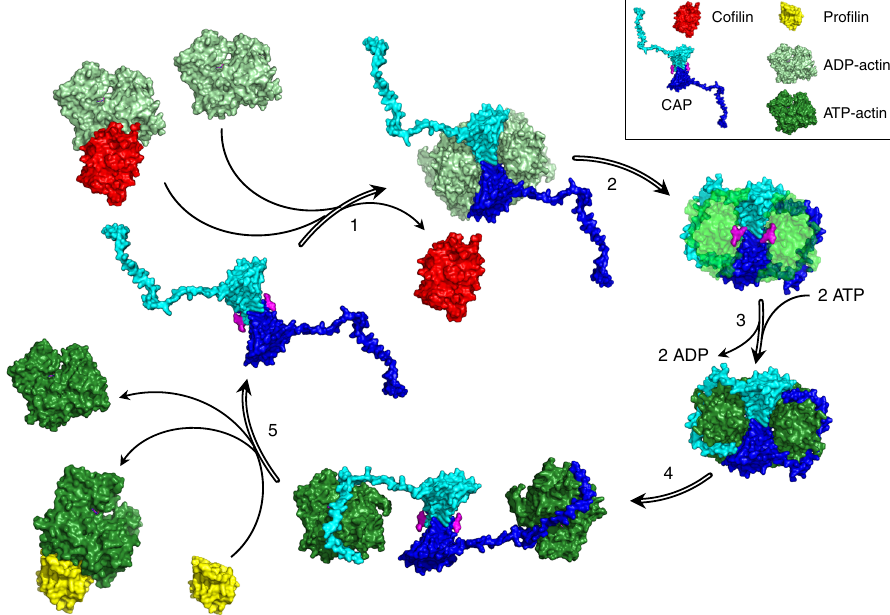
Fig. 6 A working model for how CAP catalyzes nucleotide exchange on actin monomers in cells. (1) CAP can interact with both free and co fi lin-bound ADP- G-actin using CARP domain. This interaction puts the WH2 domain in position to competitively replace co fi lin, leading to co fi lin dissociation from the ADP- actin monomer, as previously observed biochemically 20 . (2) The tight association of both CARP and WH2 domains with ADP-actin monomers, together with the penetration of the C-terminal tail of CAP into the nucleotide-binding pocket, catalyzes a change in conformation and dynamics of the ADP-actin monomer to enhance the rate of nucleotide exchange. (3) Nucleotide in actin is rapidly exchanged from ADP to ATP. (4) The CARP domain has little if any af fi nity for ATP-actin, leaving dimeric CAP molecules associated with ATP-G-actin solely through their WH2 domains. (5) Pro fi lin has high af fi nity for ATP- actin monomers, and binds directly to the PP1 domain of CAP 31 , adjacent to the WH2 domain. Thus, as ATP-actin monomers dissociate from CAP, they are rapidly bound by pro fi lin, replenishing the pool of ATP-actin monomers available for assembly. This leaves CAP primed for the next round of